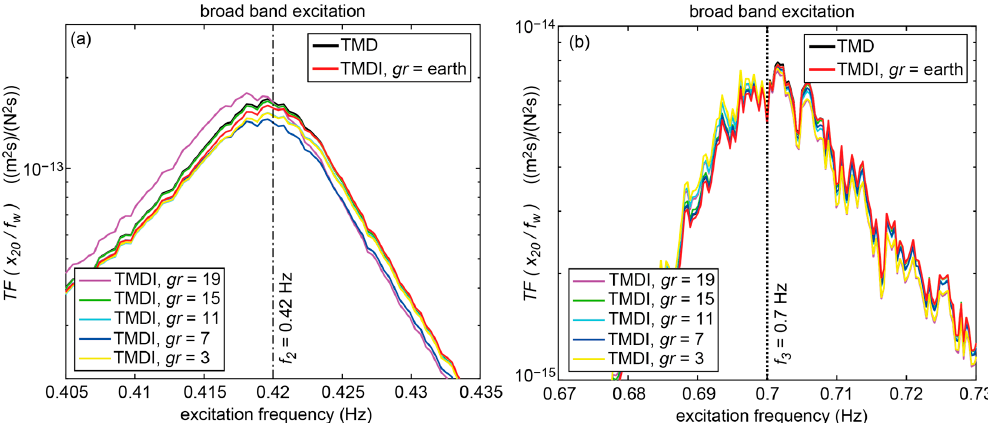
Figure 4. Results for the frequency range of mode 1: ( a ) transfer function between the structural displacement of level 20 and the excitation force; ( b ) transfer function between the structural acceleration of level 20 and the excitation force; ( c ) transfer function between the relative pendulum motion and the excitation force.